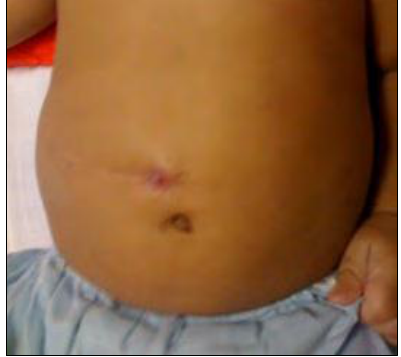
Figure 5: Appearance of stoma after few months of operation.